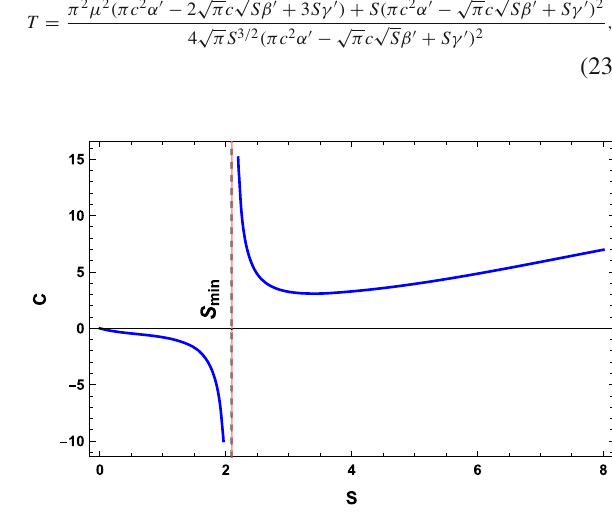
Fig. 1 Canonical ensemble: the Gibbs free energy as function of the temperature for m g = 1 , c = 1 , α = 1 and β = 2